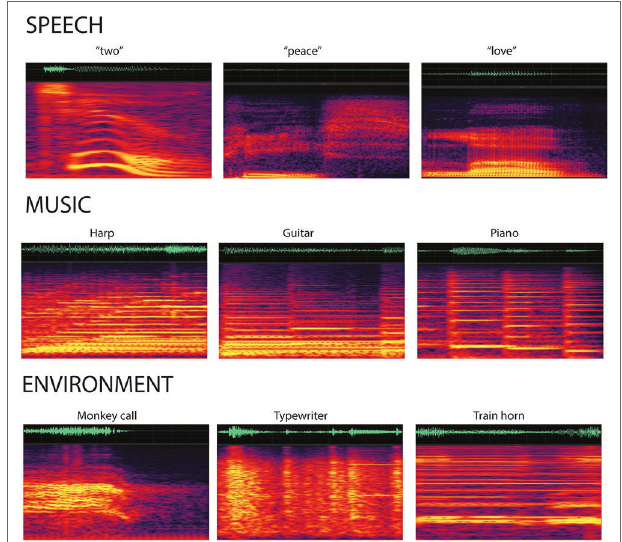
FIGURE 1 | Spectrogram of the categorical sounds. A sample of the sounds from each stimulus category displays the waveforms and spectrograms for the speech (top row), music (second row), and environmental (third row) sounds. Categorical sounds were novel (i.e., did not repeat) within each condition.